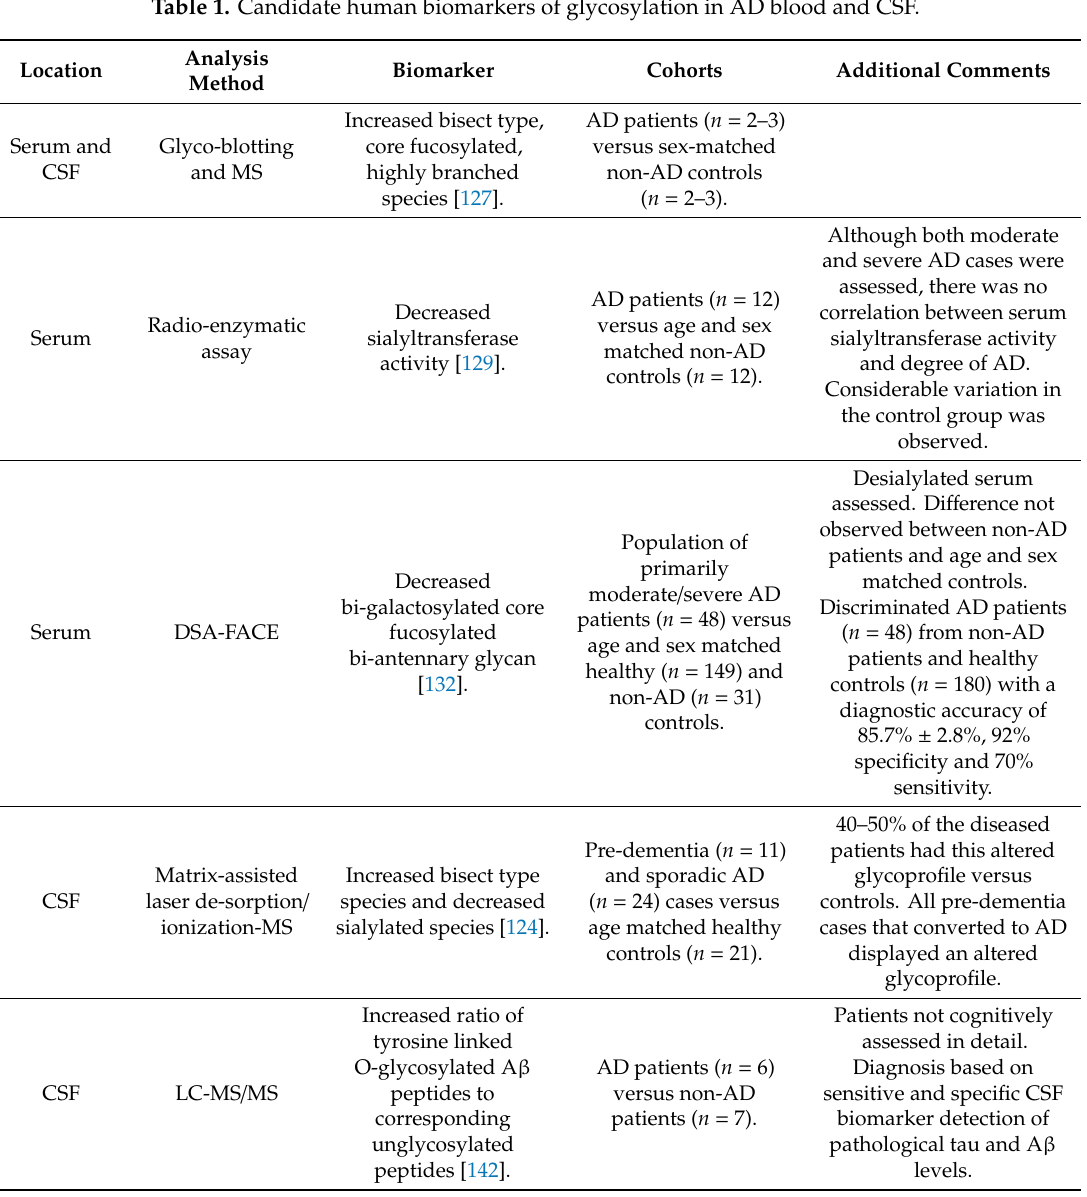
Table 1. Candidate human biomarkers of glycosylation in AD blood and